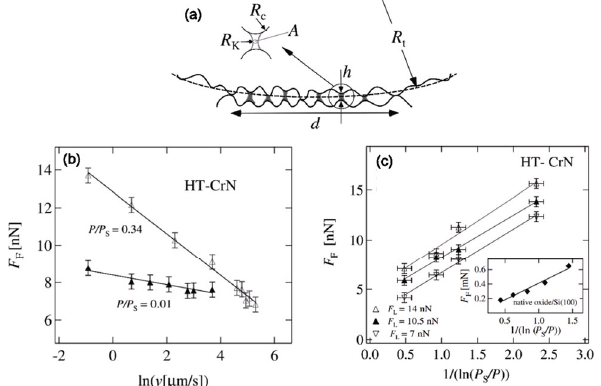
Fig. 7 (a) Friction behaviors at microscale/nanoscale level explained by a multi-asperity contact model; (b) schematic of multi-asperity contact with condensation of water bridge; (c) friction force as a function of sliding velocity, ln[ v (µm/s)] and relative humidity, 1/ln( P S / P ) or 1/ln(1/RH), on hydrophilic HT-CrN surface. Inset in (c) shows friction force vs. 1/ln( P S / P ) on native oxide-covered Si(100) surface. Reproduced with permission from Ref. [91], © American Physical Society